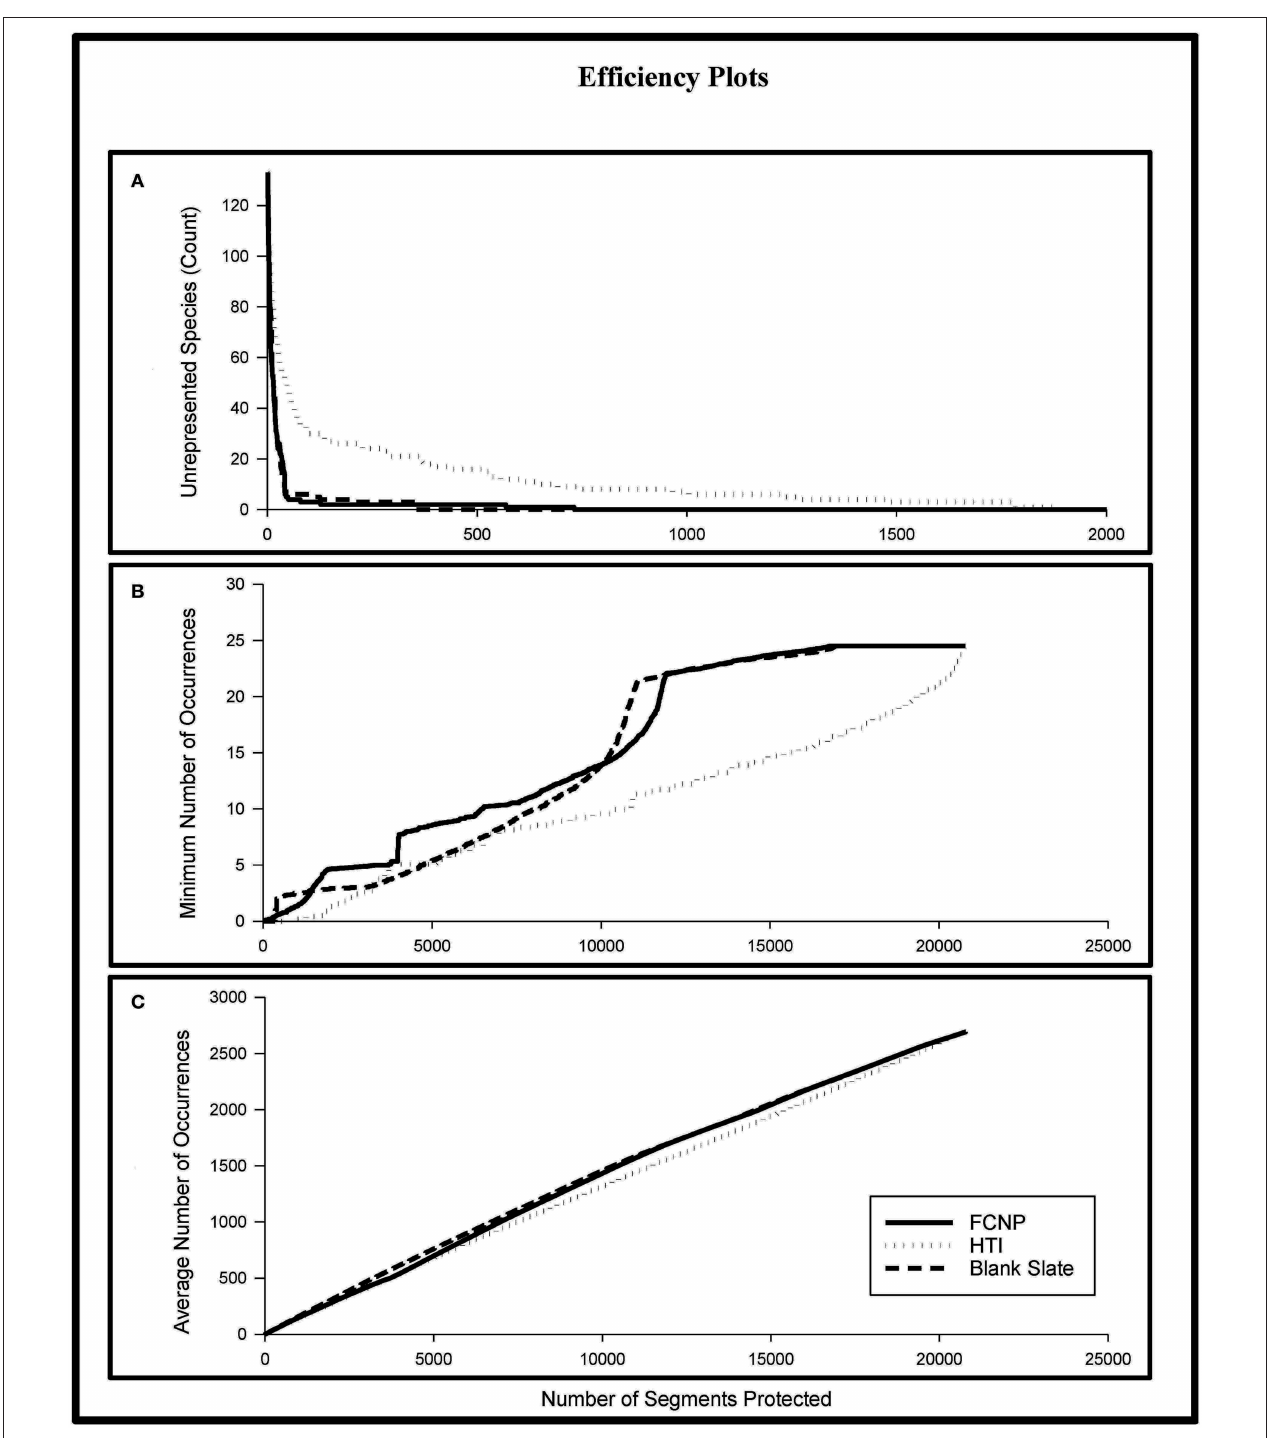
FIGURE 4 | Differences in species representation for the FCNP, HTI, and Blank Slate prioritization approaches. Moving from left to right across the x-axis represents increasing levels of cumulative protection from only the highest priority stream segment (leftmost) to all stream segments (rightmost). (A) shows the number of species unrepresented; (B) shows the minimum level of representation; (C) shows the average level of representation. The steep increase in the minimum number of occurrences in (B) for the FCNP is due to the inclusion of high value complementary areas outside of the established network once all segments within the network have been included in the solution. FCNP, Freshwater Conservation Network Prioritization; HTI, Human Threat Index.